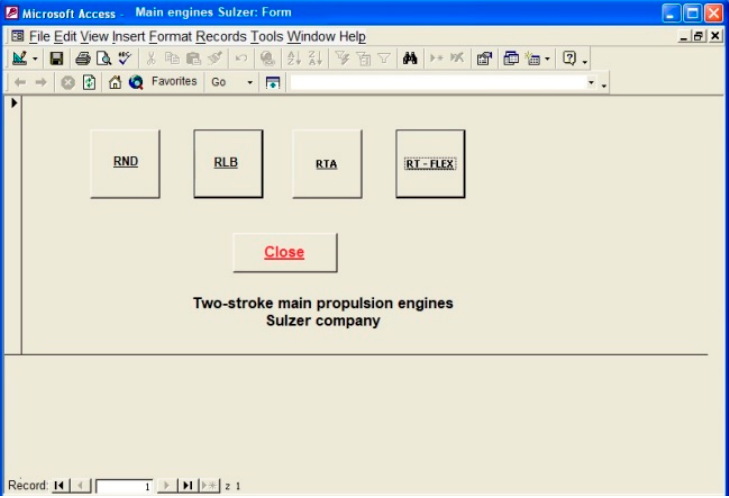
Figure 4. Form of manufacturers of the four-stroke engines: ABC—Anglo Belgian Corporation,